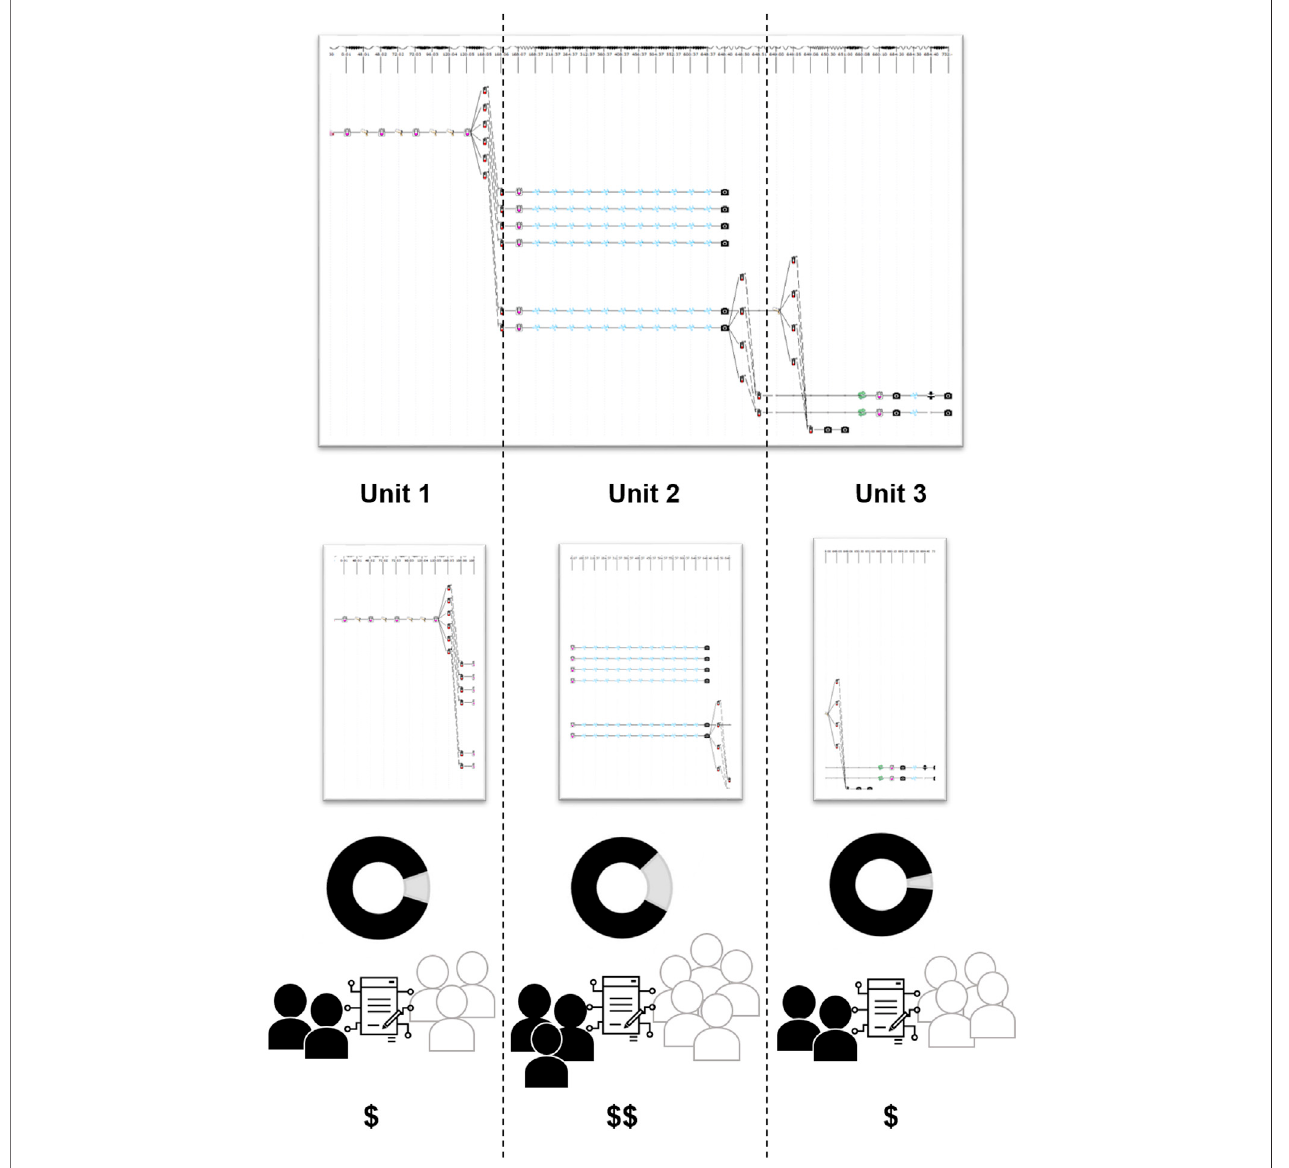
FIGURE1| P2Ppublication model. Preregistered experimental design encoded with ProtocolNavigator (top panel) isdividedinto three units (middle panel).Smart contract determines the shared authorship for each unit (bottom panel) between researchers (dark fi ll) and reviewers (no fi ll) along with journal fee for each unit (dollar